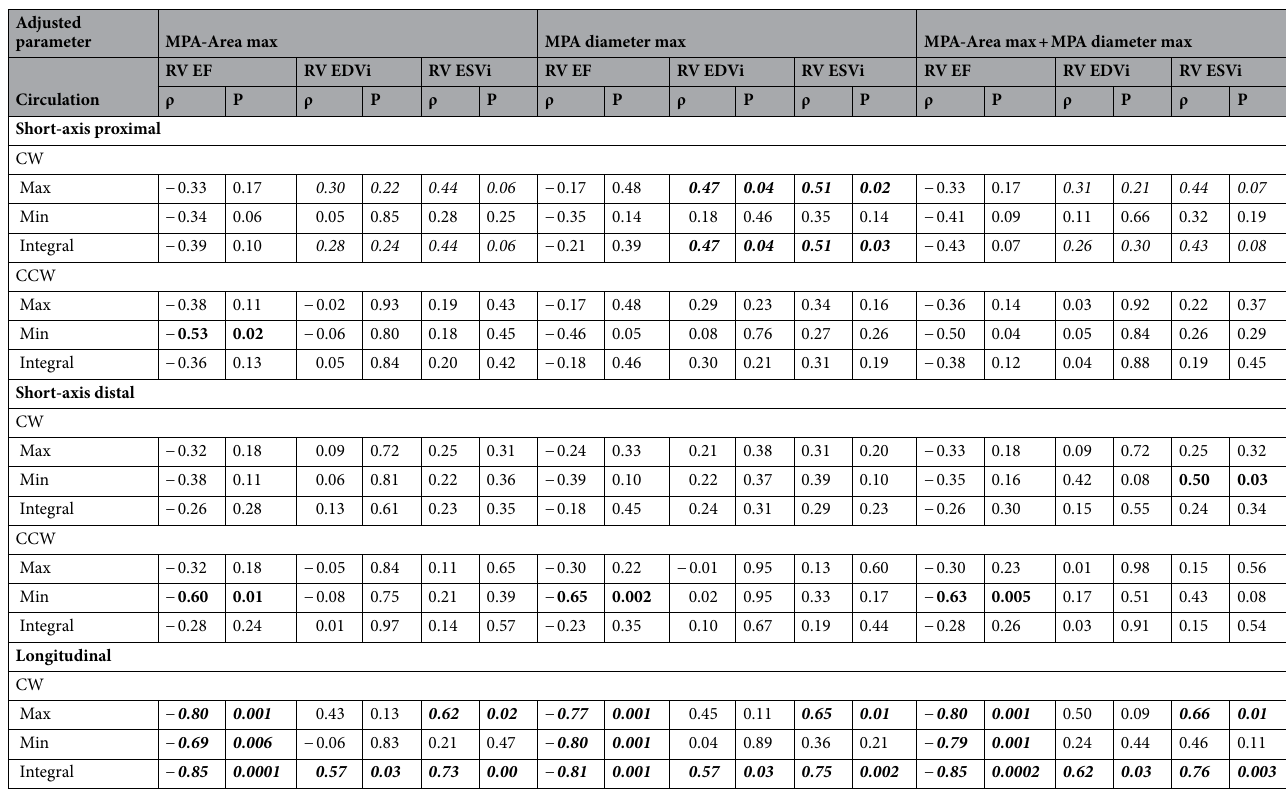
Table 5. The partial correlation coefficient between the circulation and right ventricular function adjusted based on the size of the pulmonary artery. After adjustment of the area of the MPA, the partial correlation between the short-axis proximal MPA and RV measurement was not significant. Partial correlation analysis after adjustment based on the diameter of the MPA showed a significant correlation between the counterclockwise Min circulation in the short-axis distal MPA and RVEF. Partial correlation analysis, after adjustment based on the area of the MPA, showed a significant correlation between the clockwise longitudinal circulation and RVEF, RVEDVi, and RVESVi. P-value (P) from Spearman signed rank test. Boldface indicates statistical significance (p < 0.05). Italic typeface indicates statistical significance by univariate analysis (p < 0.05 in Table 4). MPA main pulmonary artery, RV right ventricular, EF ejection fraction, EDVi end-diastolic volume indexed for body surface area, ESVi end-systolic volume indexed for body surface area, CW clockwise,